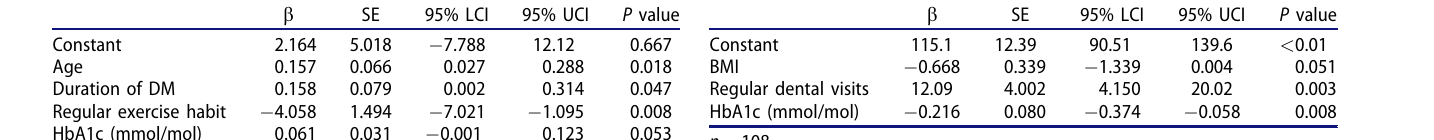
Table 4. Multiple linear regression analysis of exposure variables on the sum of decayed, missing, and filled teeth.